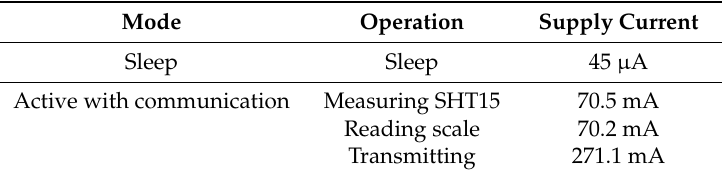
Table 2. Measured power consumption of the node.